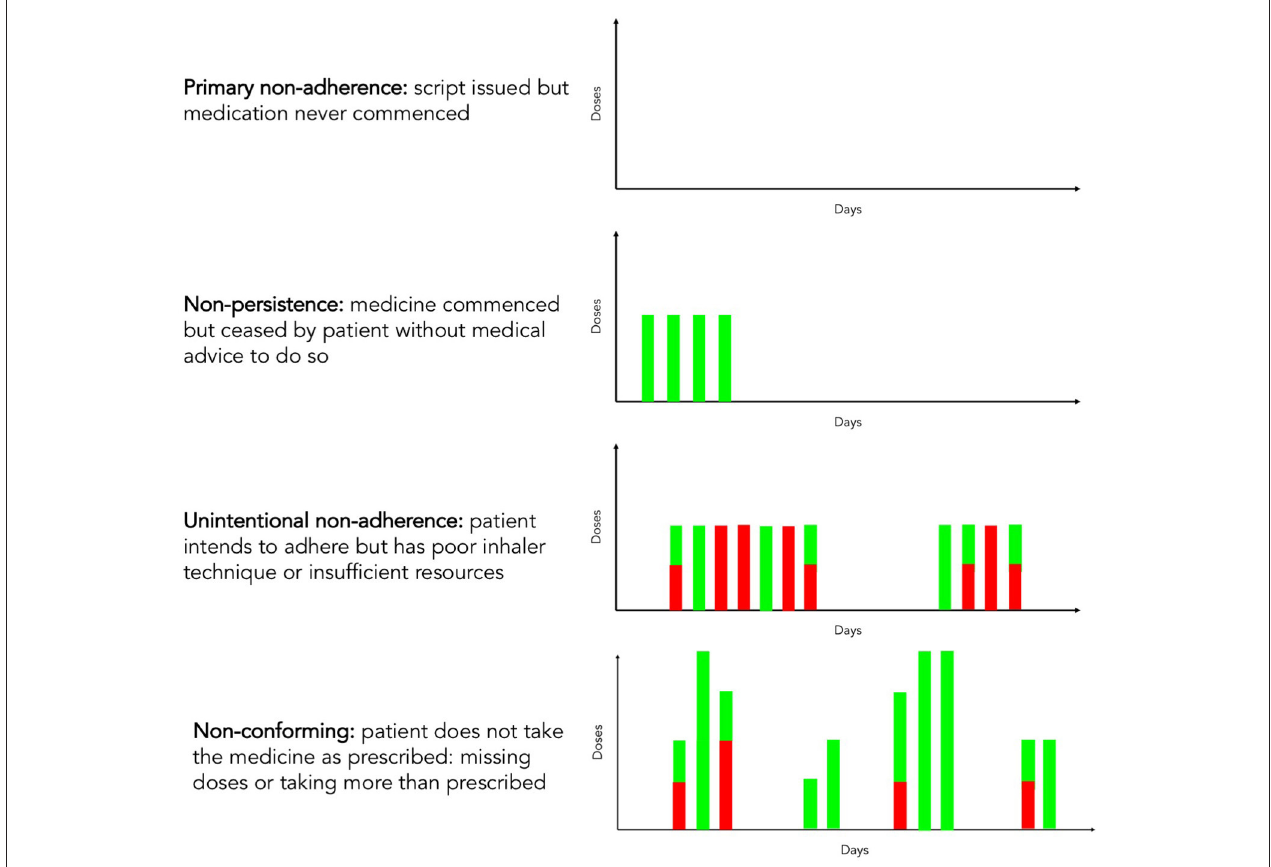
FIGURE 1 | Adherence and competence with respect to inhaler use. Green columns represent inhaler doses correctly administered by the patient, and red columns represent missed or incorrectly administered doses due to poor inhaler technique, insufficient resources or